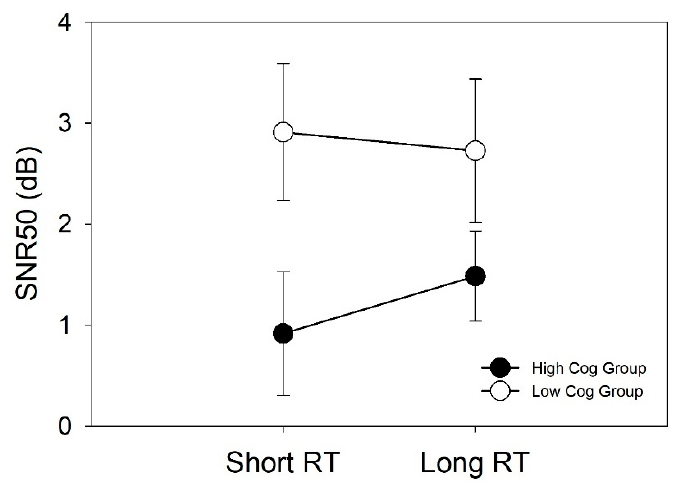
Figure 7. Interaction between cognitive performance group and RT when mean SNR50 scores of the three speech recognition tests were combined. Error bars represent standard errors. Table 3. Mean SNR50 (dB) for the two RTs and the two cognitive performance groups. Values enclosed in parentheses represent one standard deviation (N =